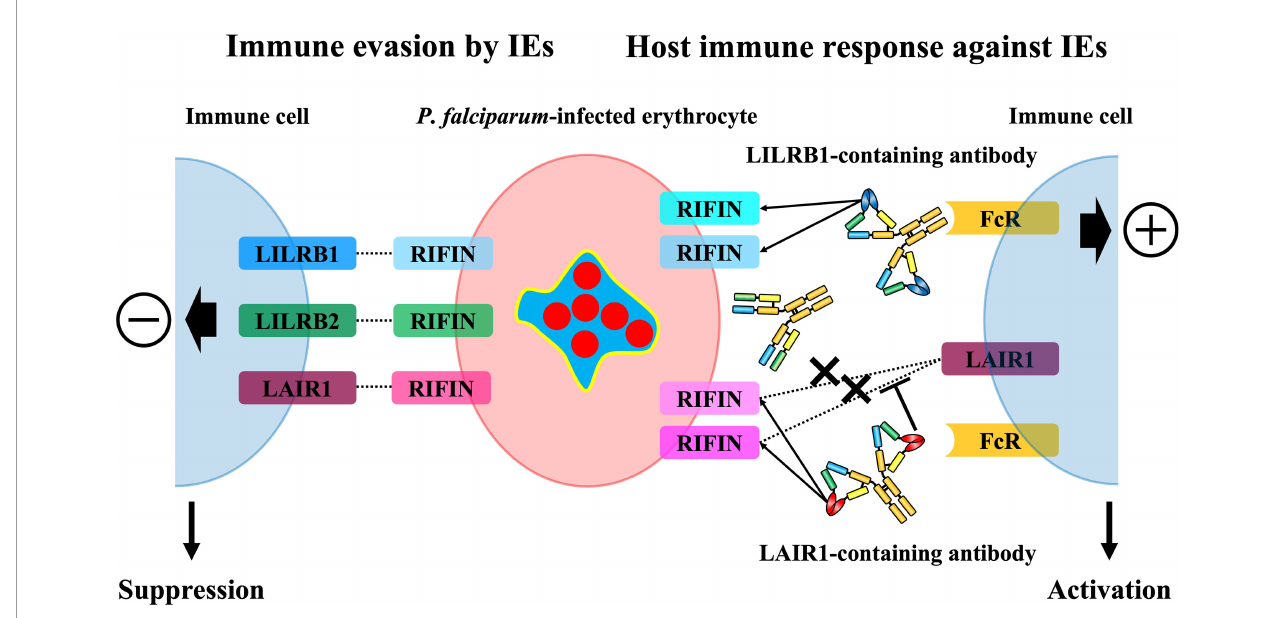
FIGURE 3 | The immunosuppressive functions of RIFINs towards host immunity and the host immune response against RIFINs. Some RIFINs bind to the human inhibitory immune receptors and induce the inhibitory signal to the host immune system, and it is suggested that LILRB1-binding RIFINs may contribute to the severity of malaria. The host conversely induces normal antibodies against RIFINs and specialized antibodies that contain a portion of the immune receptors to block the RIFIN-receptor interaction and broadly recognize IEs expressing LAIR1 or LILRB1-binding RIFINs and promote the elimination of these